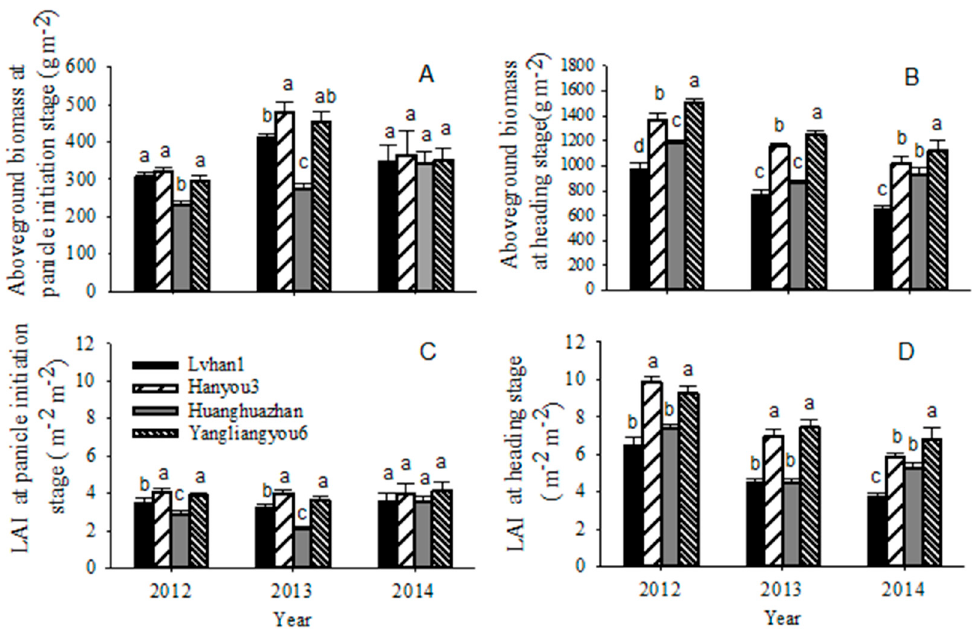
Figure 2. Aboveground biomass at the panicle initiation ( A ) and the heading ( B ) stages, and leaf area index (LAI) at panicle initiation ( C ) and heading ( D ) of four tested cultivars in all three years. Lvhan1 (inbred) and Hanyou3 (hybrid) are typical upland rice cultivars. Huanghuazhan (inbred) and Yangliangyou6 (hybrid) are well-known lowland rice cultivars. Error bars represent SE. Different letters in each year means the significant differences at 0.05 level. Data were recorded based on the sampling area of 0.5 m 2 .